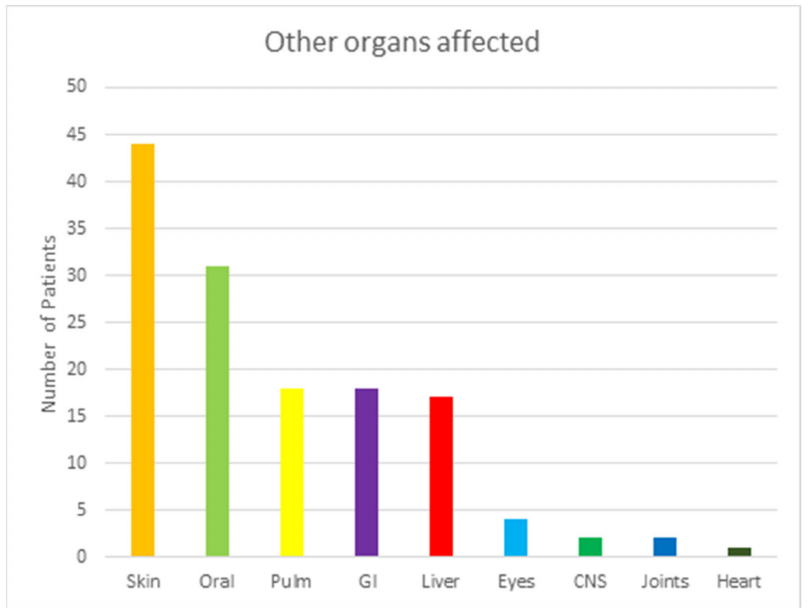
Abbreviations: Pulm, Pulmonary; GI, Gastrointestinal tractus; and CNS; Central Nervous